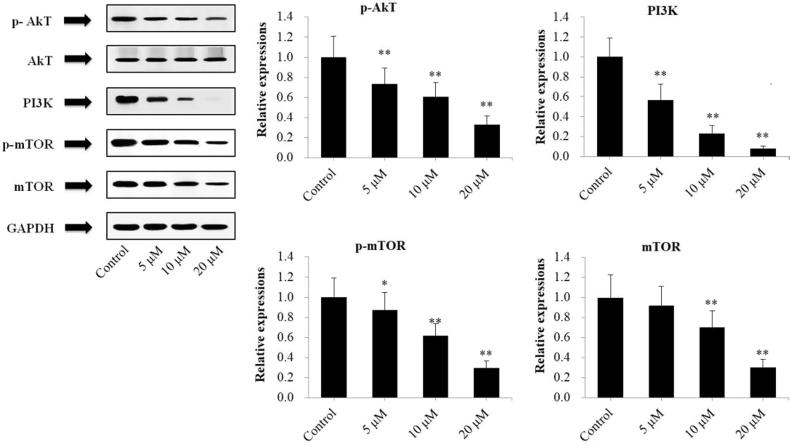
Exposure of U266 cells to DMEC inhibited the PI3K/Akt/mTOR signaling pathway. U266 cells were treated with DMEC (5, 10, and 20 μM) for 24 h, and protein expression levels were determined by western blotting analysis with antibodies against p-Akt, Akt, PI3K, p-mTOR and mTOR. Data are presented as the mean ± standard deviation (n = 4). *p < 0.05, **p < 0.01 vs. control group.